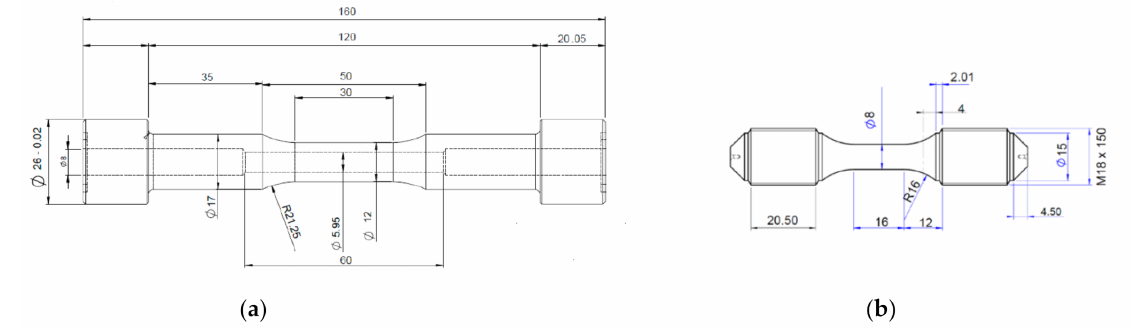
Figure 1. Specimen design of the: ( a ) hollow specimen; ( b ) solid specimen (scale in